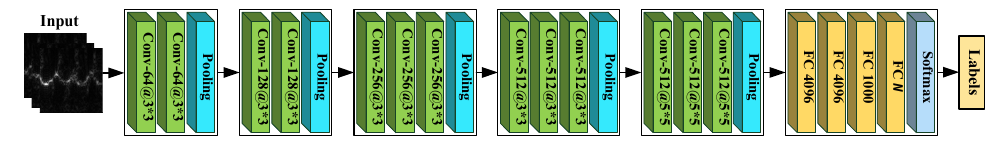
Figure 5. The DCNN architecture.